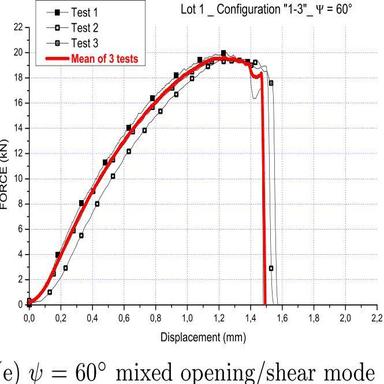
Force vs. displacement responses for pure opening mode (a) ψ = 0∘ , pure shear mode (b) ψ = 90∘ and mixed opening/shear mode (c) ψ = 30∘ , (d) ψ = 45∘ , (e) ψ = 60∘ .